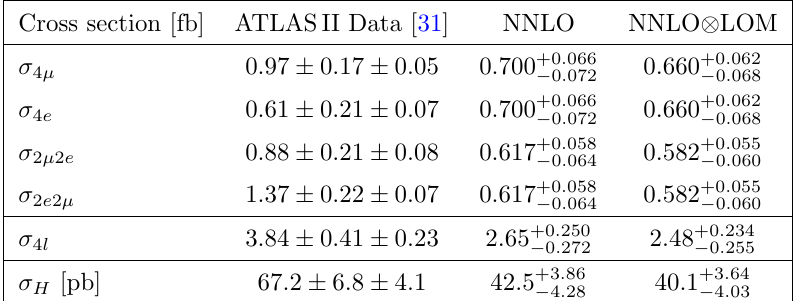
Figure 7. Jet multiplicity in Higgs-plus-jet production up to NNLO for CMS [ (cid:31) (upper-left) and [ (cid:31) dt =137.1 fb − 1 ] (upper-right), ATLAS I [ L ATLAS II [ (cid:31) dt =79.8 fb − 1 ] (lower-right) cuts and integrated luminosities. NLO and NNLO EFT L predictions are re-weighted by LO quark mass effects.